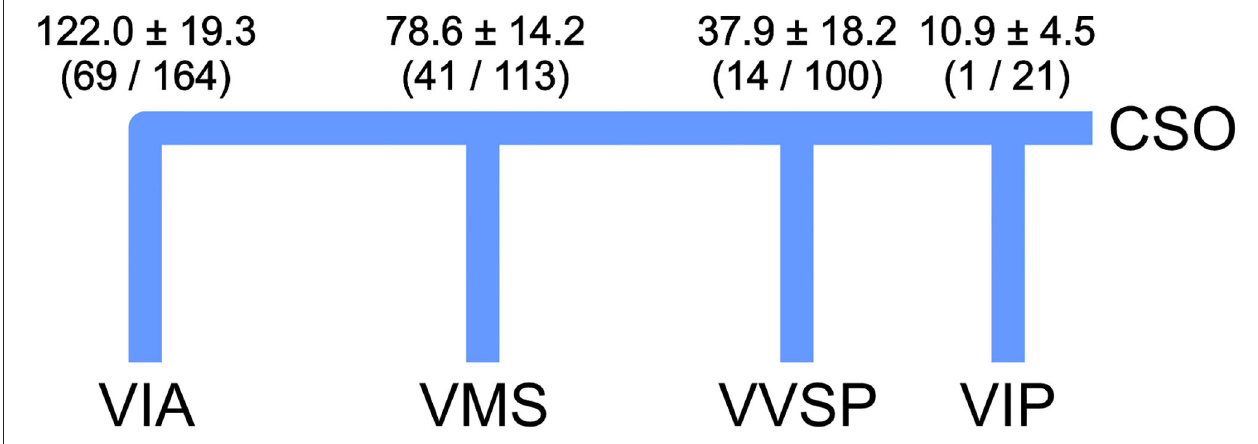
FIGURE 5 | Mean position ± standard deviation of the venous tributaries as relative distances to the ostium of the coronary sinus (CSO) inspected by CT ( n = 53). Values include double tributaries for VVSP (6 × 2) and VMS (1 × 2). Minimum and maximum values in brackets. Values are given in mm. VIA, V. ventricularis anterior ; VIP, V. interventricularis posterior ; VMS, V. marginalis sinistra ; VVSP, V. ventriculi sinistri posterior